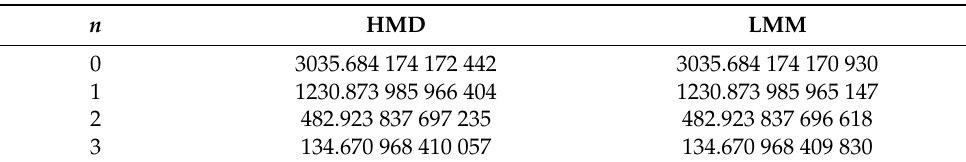
Table 2. The negative of the complete energy spectrum (in units of 1/ a 2 ) for the poten- tial V II ( x ) obtained using LMM and HMD techniques for the potential parameter values: { a , A , B , C } = { 1,10,1000,500 } making N = 19. For the LMM, the variational parameter h = 0.0028 and a grid size M = 100 are used, whereas for the HMD, the scale parameter λ = 250 and a matrix size M = 100 are used.